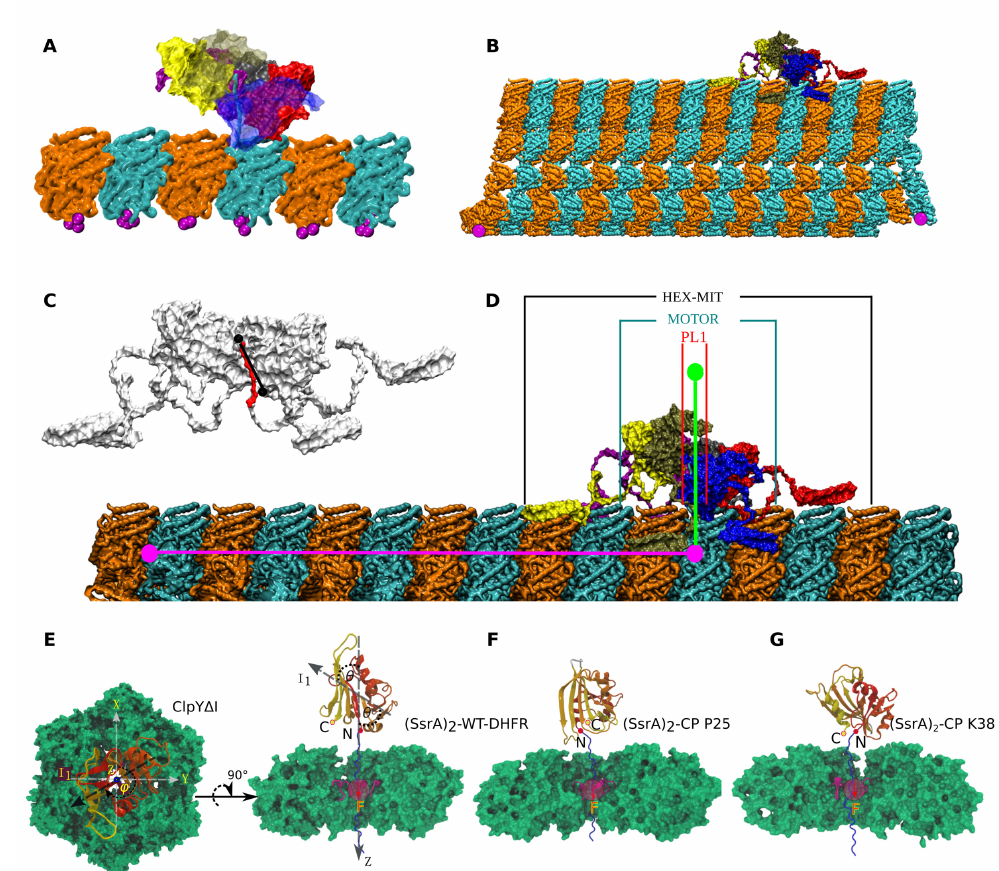
Figure 1. Configurations for the spastin and ClpY machines and their substrate proteins (SP) probed in our simulations. ( A ) Side view of the spastin motor mounted on a MT3 × 3 fragment ( α tubulin: orange, β tubulin: cyan, fixed residues: magenta); ( B ) side view of the entire spastin machine mounted on an 8-dimer long, 13 PF MT lattice; ( C ) cut-out side view of the HBD (red) bound in the central pore of the spastin hexamer. The largest axis of inertia of the pore loops 1 is indicated by the black line; ( D ) side view of the spastin machine mounted on a PF showing the various angles calculated in our pulling simulations: between the main axis of the PF (pink) and the principal axis of symmetry of the spastin machine (HEX-MIT), of the spastin motor only (Motor), or of the pore loops 1 (PL1) only (green); ( E ) Top and side view of the ClpY ∆ I (green)-SP system with polar angle θ and azimuthal angle φ are indicated in the XYZ Cartesian coordinate system. SP is a fusion protein comprising the unfolded (SsrA) 2 peptide (blue) and the DHFR domain (color-coded according to secondary structure). ClpY pore loops (red) are also indicated. An external repetitive force F is applied onto SP amino acids transiently located within the ClpY pore region (see Methods). ( F , G ) Circular permutant variants of DHFR with engineered N- and C-terminals at the ( F ) P25 and ( G ) K38 positions are also